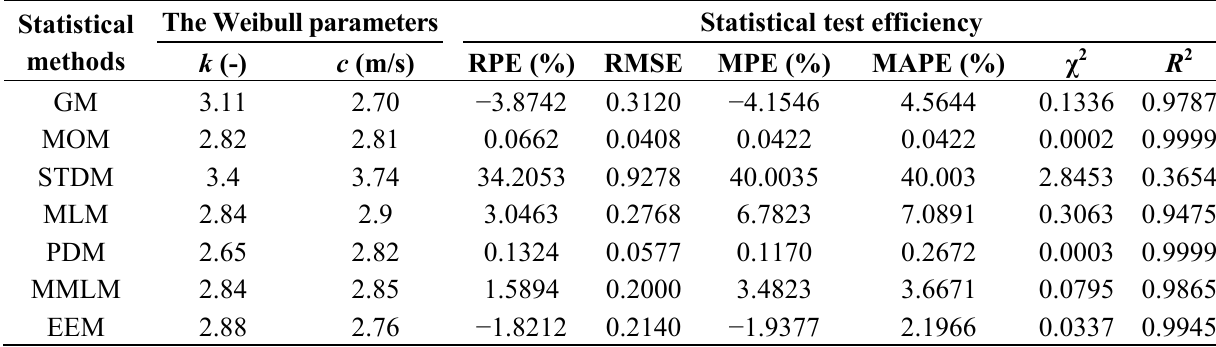
Table 6. The Weibull distribution analysis for Station-II at 20 m height.